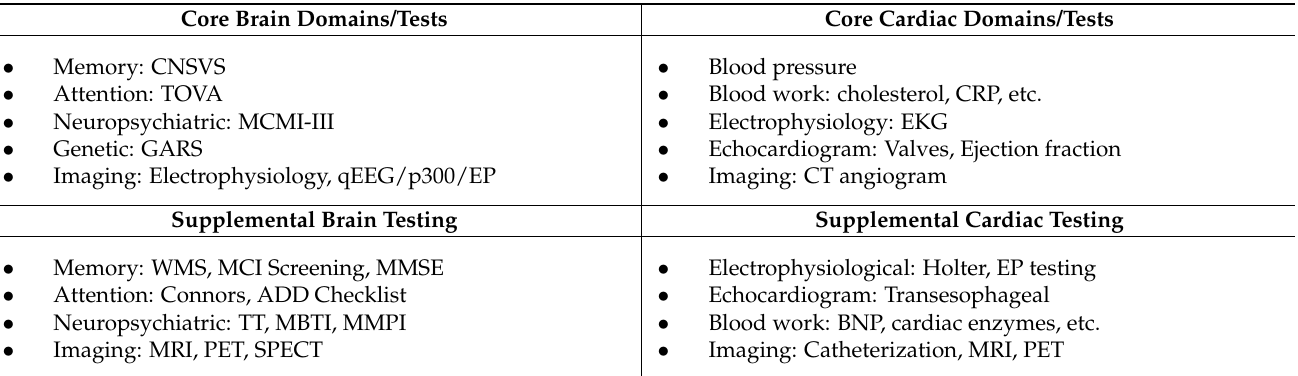
Table 3. Parallel pattern to manage brain and cardiac disease. 1